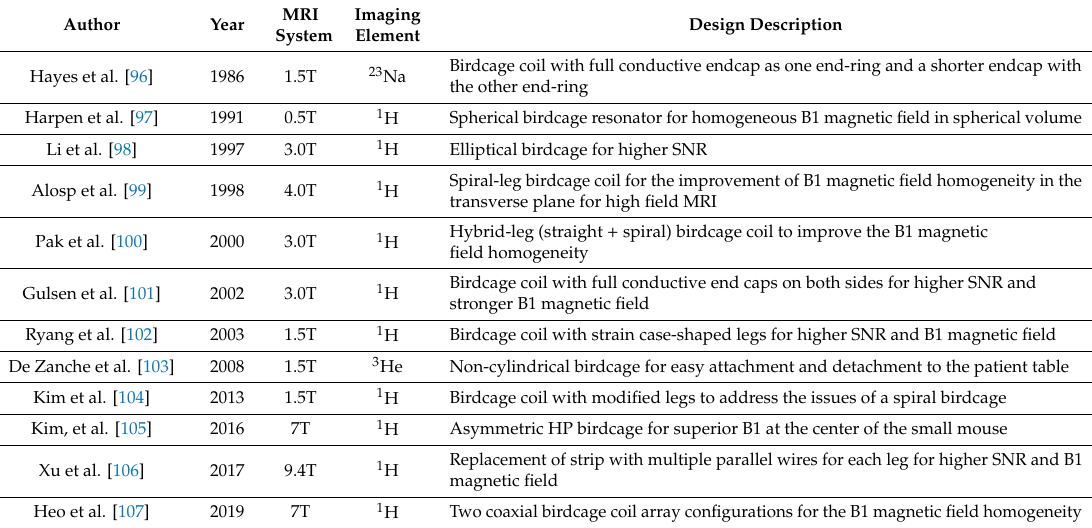
Table 2. Modified designs of the birdcage radio frequency (RF) coil.